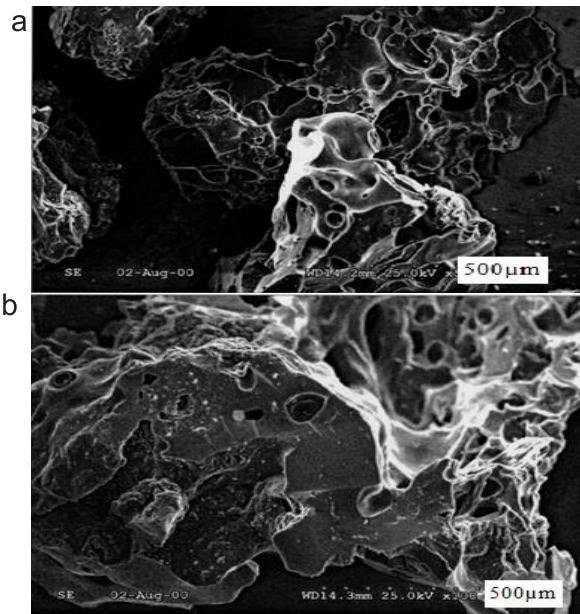
Fig. 5. SEM images of casein biochar, a. Biochar particle with porous structure.